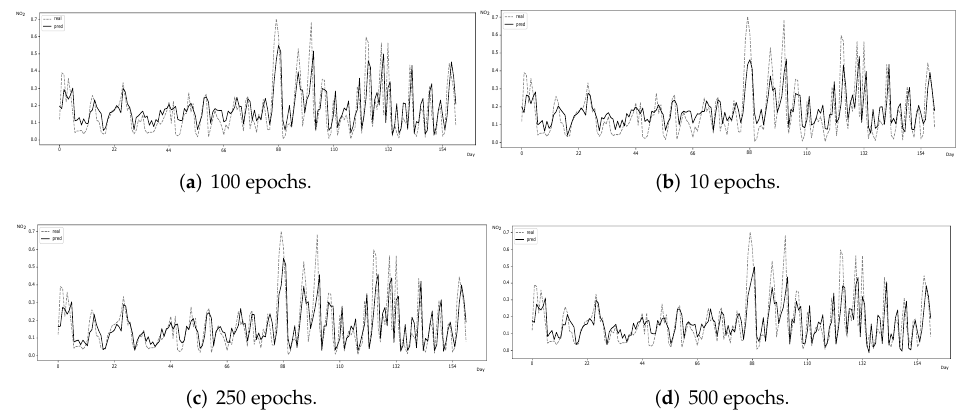
Figure 18. Predicted vs. actual normalized output values with changes in the number of epochs.